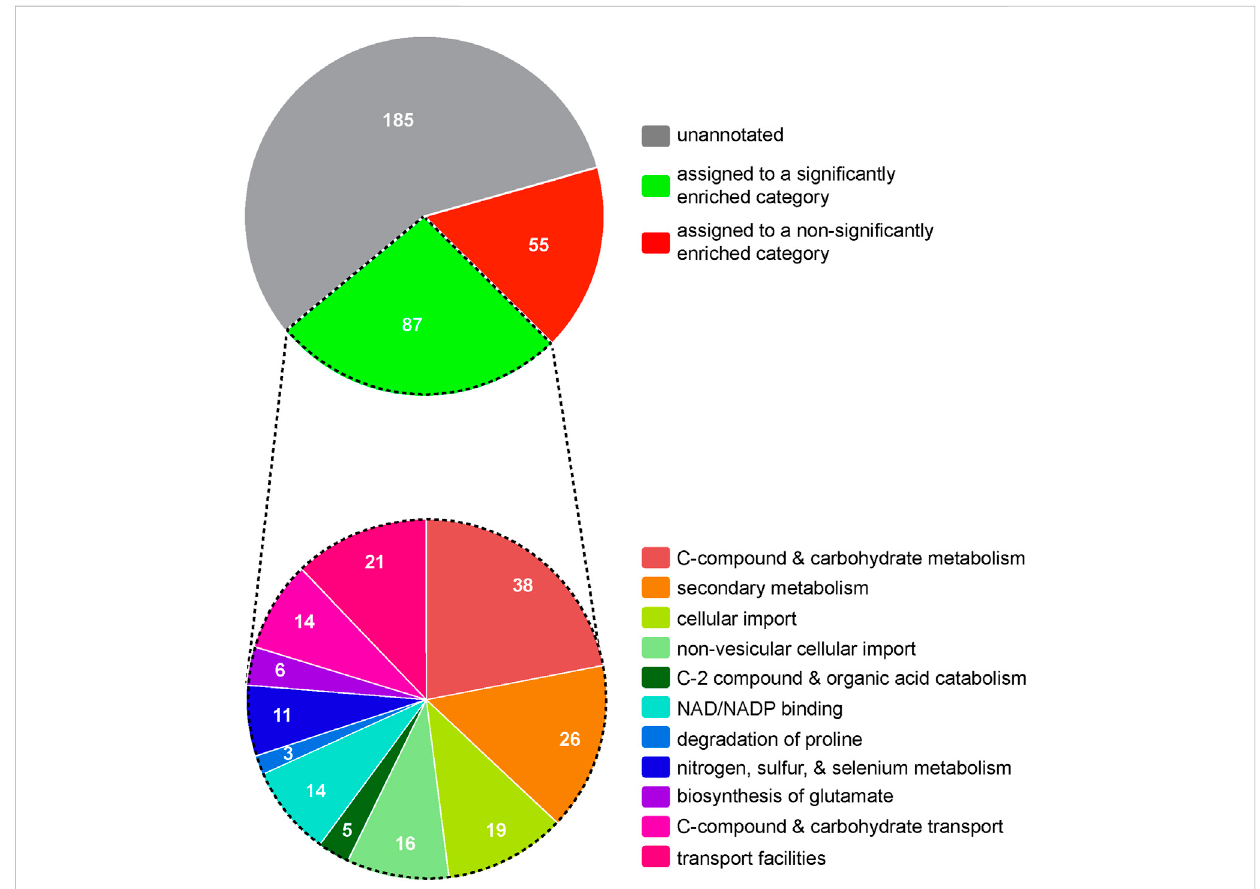
FIGURE 1 Hierarchicalontology classi fi cationenrichmentanalysesofRNAsequencingresults. The WTstrainandthe mar1 Δ mutantstrainwereconditionedin TC medium at 37 ° C and RNA sequencing analyses were subsequently performed. Prioritized signi fi cantly differentially expressed genes (log 2 fold ±1 and adjusted p -values < 0.05) were analyzed by FunCat enrichment analysis. All 327 prioritized signi fi cantly expressed genes are shown in the top pie chart, with only a subset (87 genes) being annotated and assigned to one or more signi fi cantly enriched functional categories. The functional category assignments of these 87 genes are shown in the bottom pie chart. Functional categories with an adjusted p -value < 0.05, determined by Benjamini- Hochberg false discovery rate (FDR) correction, were considered signi fi cantly enriched. Pie charts are depicted to